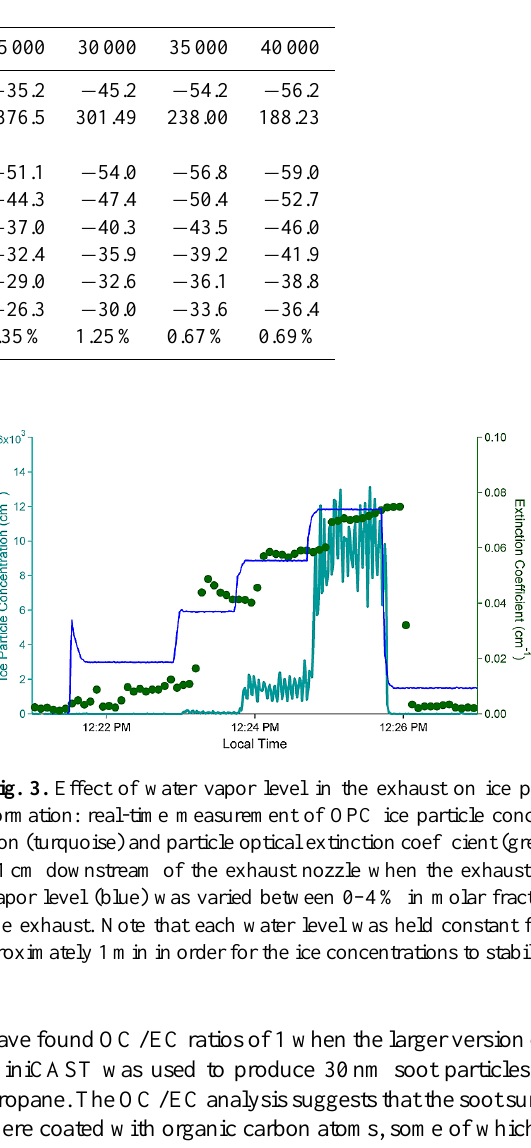
Table 1. Standard day conditions examined in our PAL work and threshold temperature and exhaust water molar fraction for contrail formation associated with each condition. The threshold conditions were calculated using the Schmidt–Appleman criterion formulated in Schumann (1996).